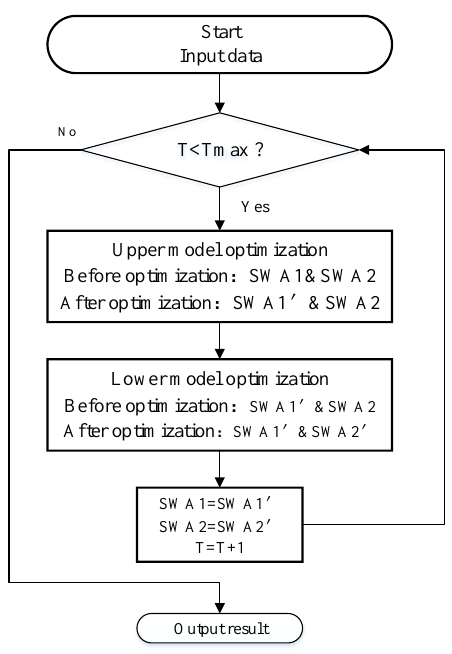
Figure 5. The flowchart for solving a bi-level optimization model.